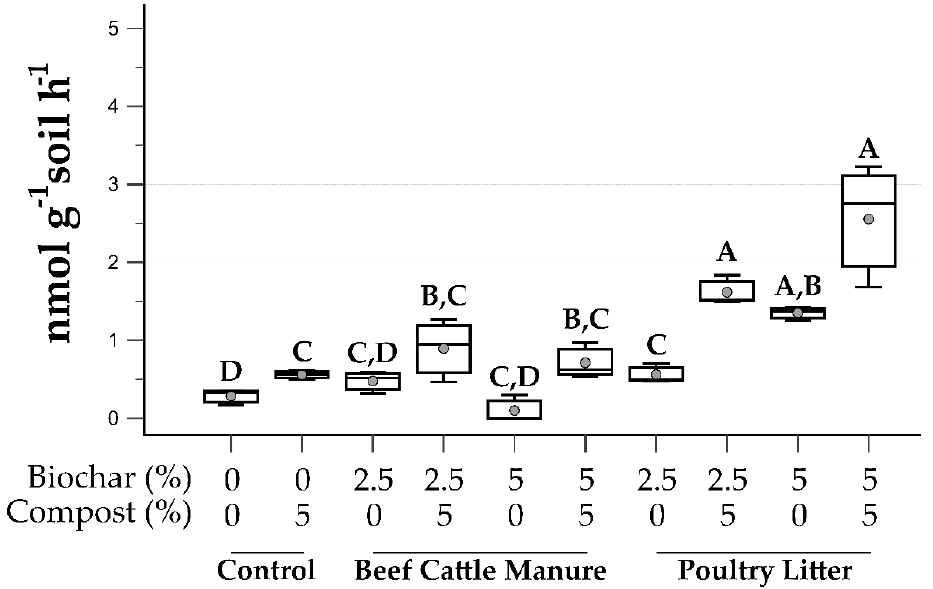
Figure 5. Soil intracellular enzyme activity as measured by esterase. Gray circles are mean values, top and bottom of boxes are 75th and 25th percentile, respectively, median is center line, and whiskers are range of the data. Treatments that do not share a letter are significantly different ( p < 0.05). Data are presented as untransformed, with statistical analysis based on log-transformed values.